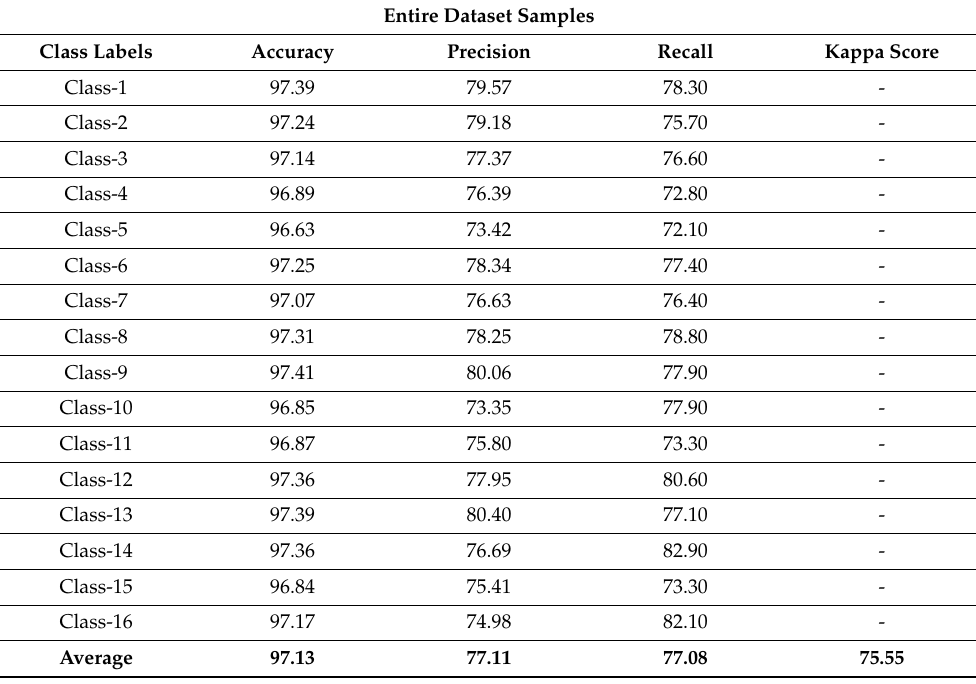
Table 4. Result analysis of the SSODTL-CC technique with distinct classes under all of dataset-2.